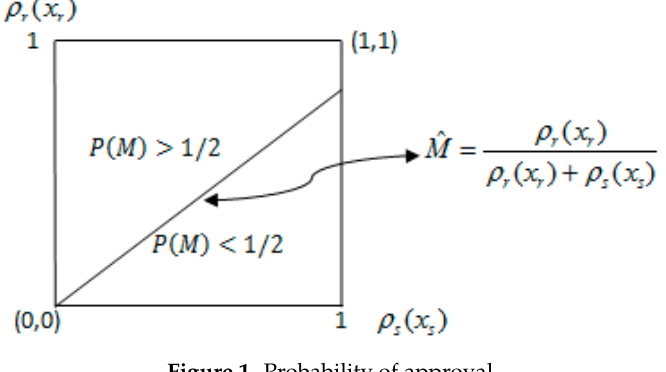
Figure 1. Probability of approval.